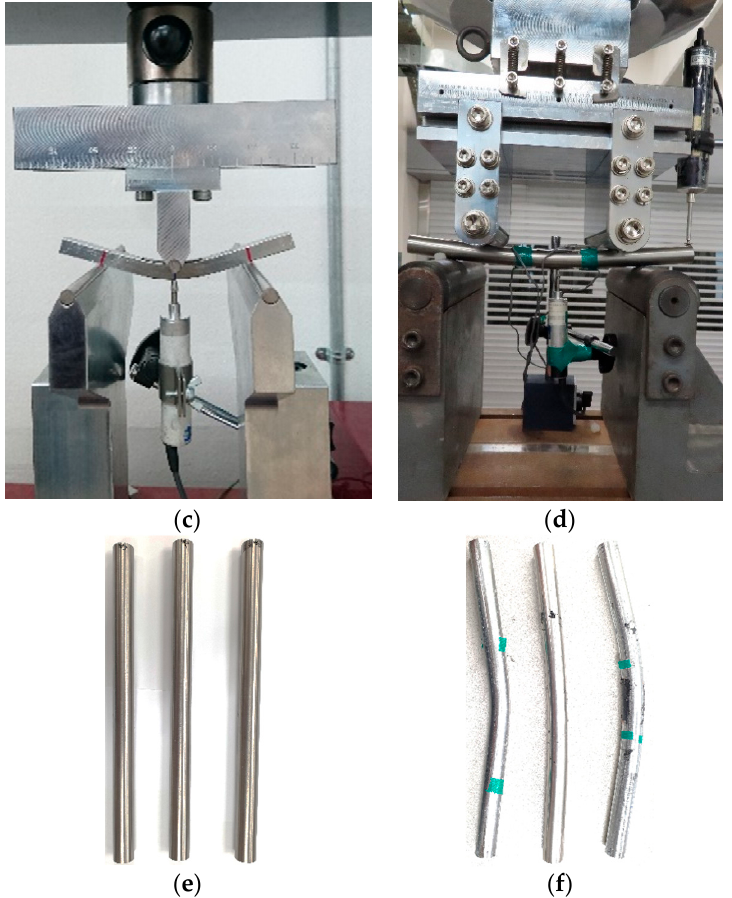
Figure 9. Experimental tests setup. ( a ) Tensile test, ( b ) compression test, ( c ) bending test for rectangular beam, ( d ) bending test for circular beam, ( e ) circular beams before bending tests, ( f ) after bending tests.